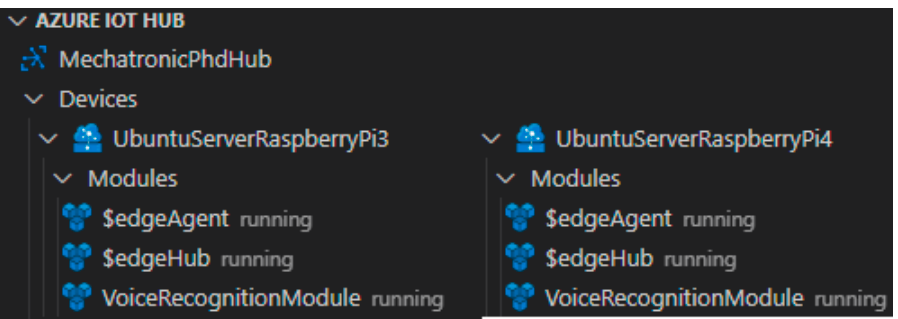
Figure 13. Visual Studio Code—debugging option. Possibility to see which modules are running on the specific devices. PC, Tinker Board 2, Raspberry Pi 3 and 4 are used in the experiment.